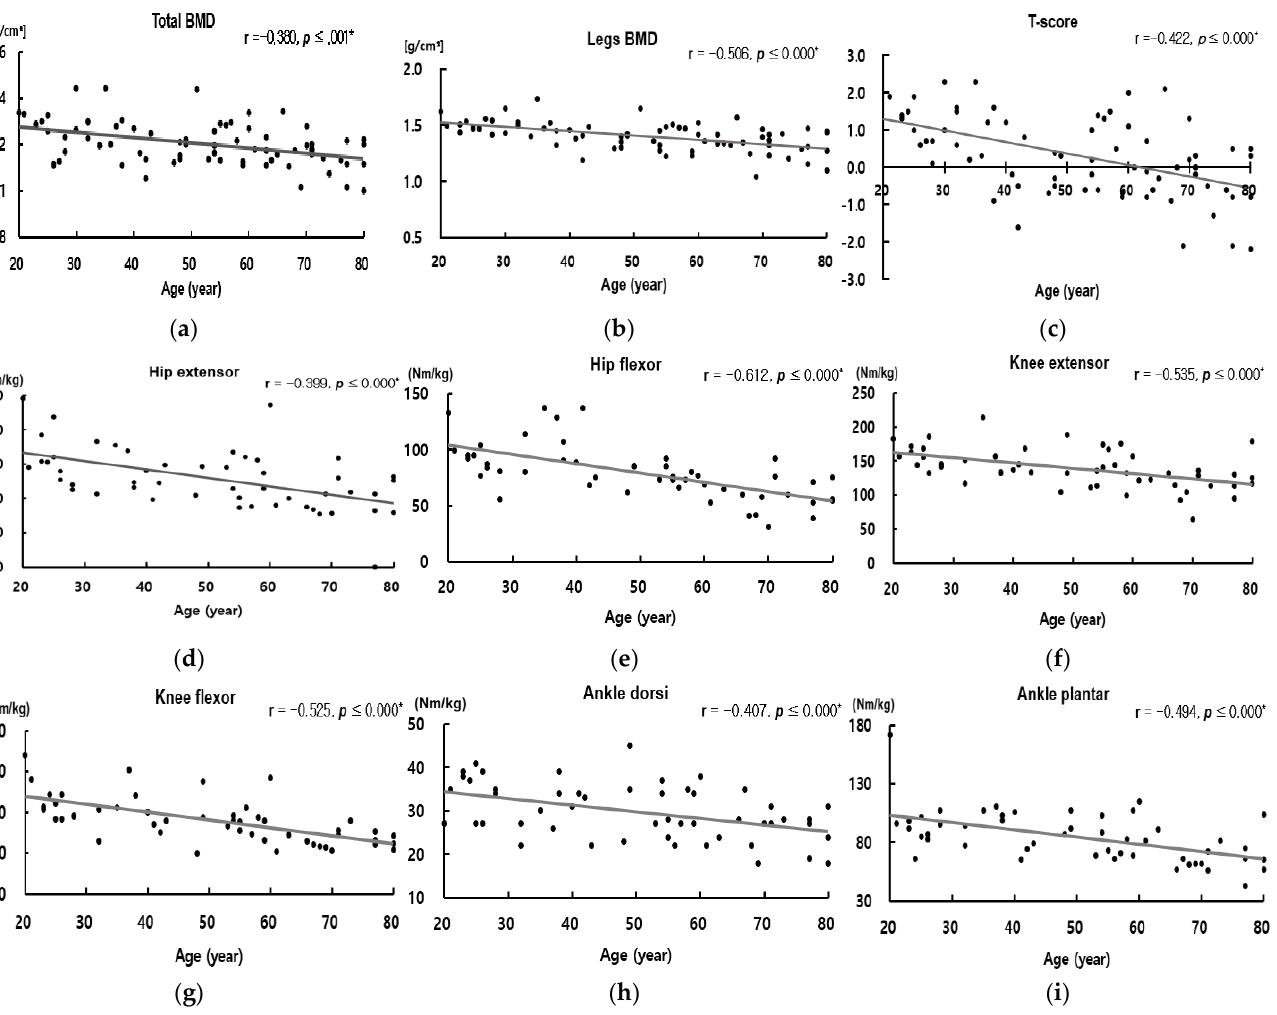
Figure A1. Correlations between age and physical characteristics (BMD and peak muscle torque). ( a ) Total BMD, ( b ) legs BMD, ( c ) T-scope, ( d ) hip extensor, ( e ) hip flexor, ( f ) knee flexor, ( g ) knee extensor, ( h ) ankle dorsi flexor, ( i ) ankle plantar flexor. * p < 0.05 indicates significant correlations between age and the variables.